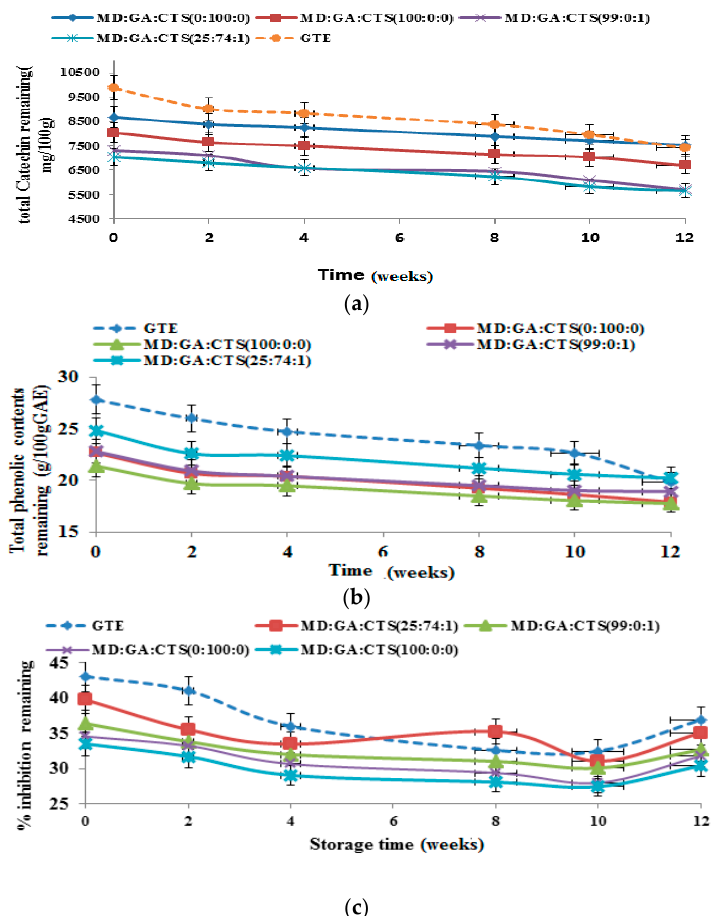
catechins; ( b ) total phenolic content; and ( c ) antioxidant activity stored at 25 ˝ C for 12 weeks. Values are means of three replicate sample determinations ˘ SD. (MD—maltodextrin, GA—gum arabic,